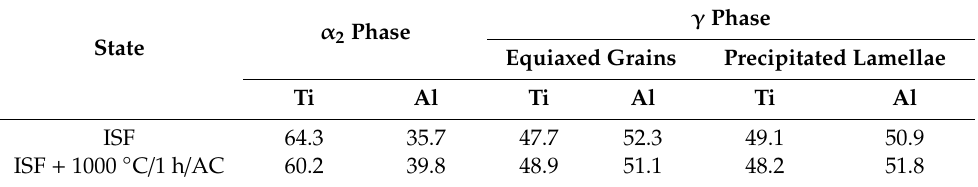
Table 1. Atomic percent (at.%) of Ti and Al elements in α 2 phase and γ phase in the isothermally forged TiAl alloy and the isothermally forged sample after heat treatment at 1000 °C for 1 h.